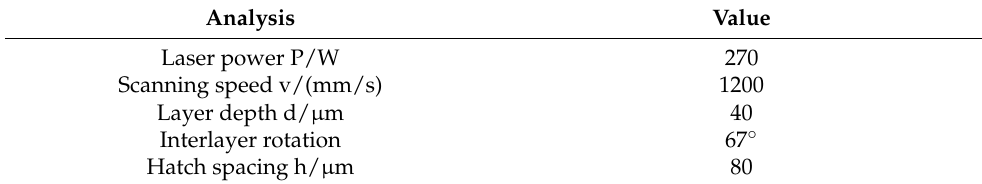
Table 2. Parameters used in the experiment.